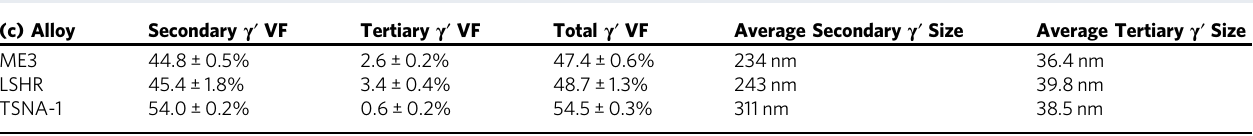
Table 1 Precipitate